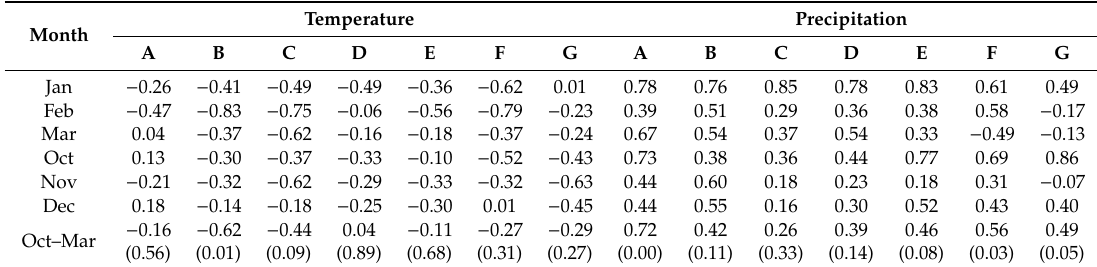
Table 6. The Pearson correlation coefficients of the inter-annual variation of the monthly NDSI and temperature / precipitation from 2001–2016.